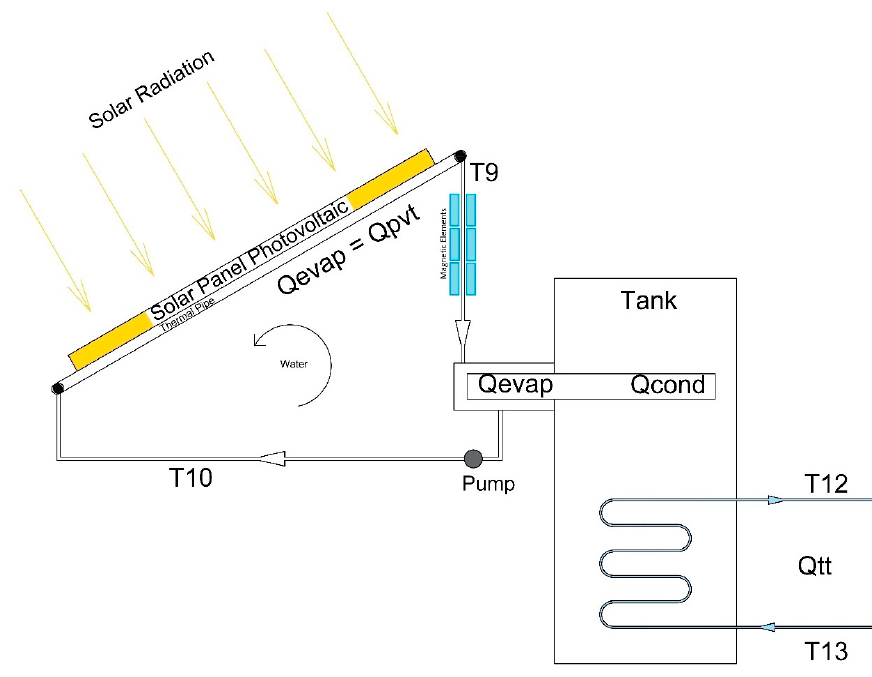
Figure 1. PV/thermal hybrid system using nanofluids with heat pipe and magnetic field.